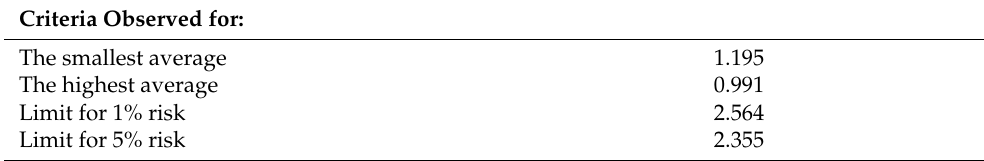
Figure 2. Within (wb) and between (bb) bottle homogeneity of the H 2 SiF 6 mass fraction of the candidate CRM. Blue, green, and orange bars show the results of first, second, and third analysis of each sample, respectively. Table 2. Means homogeneity by Grubbs